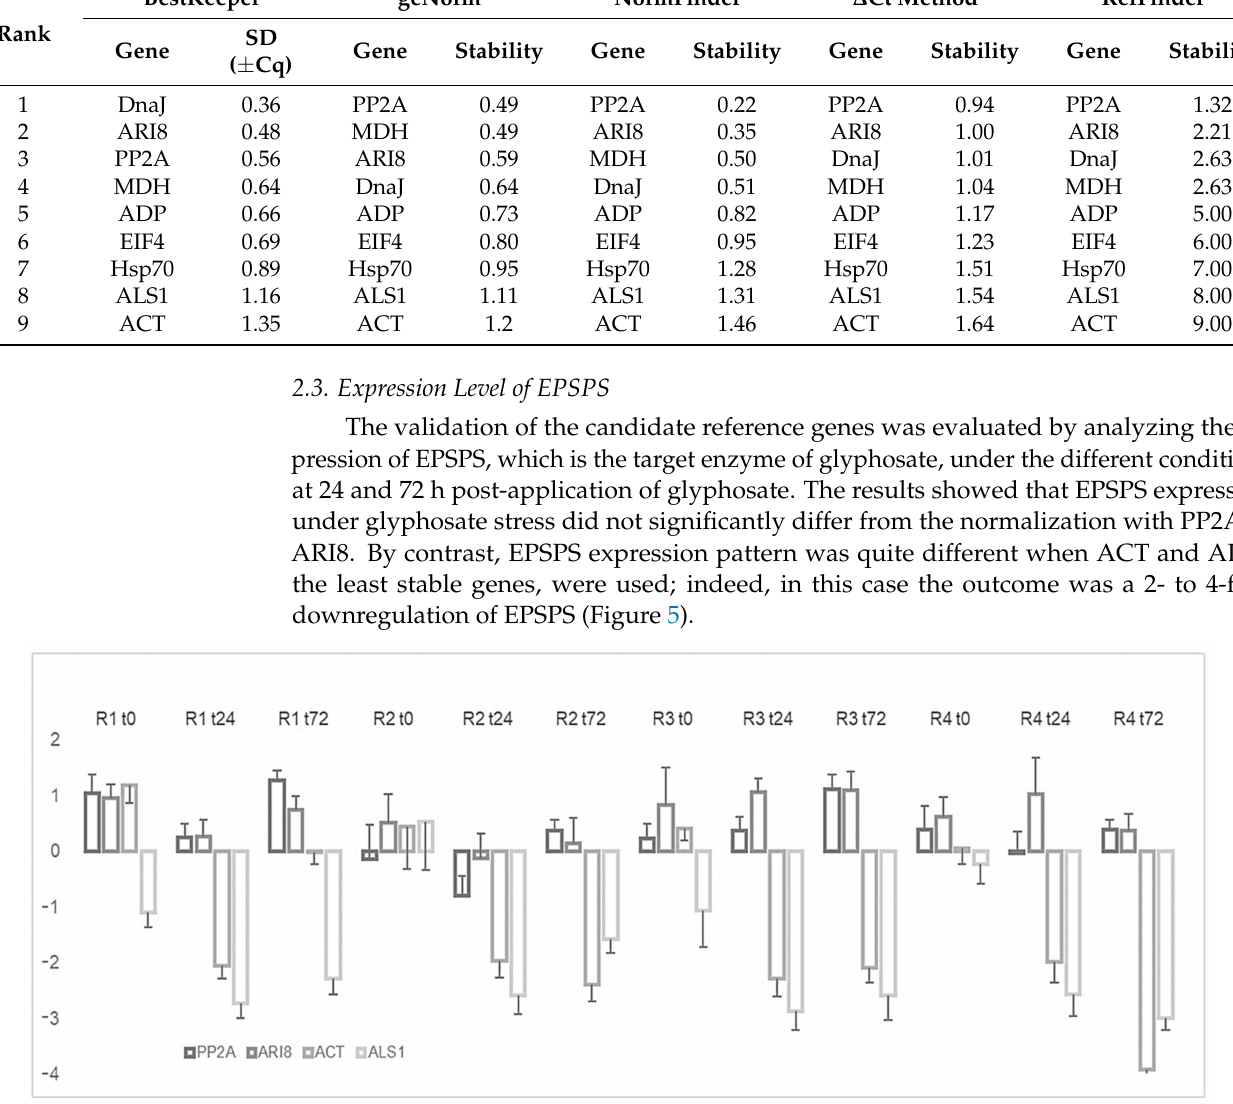
Figure 5. Relative expression of EPSPS under glyphosate stress and normalization to different reference